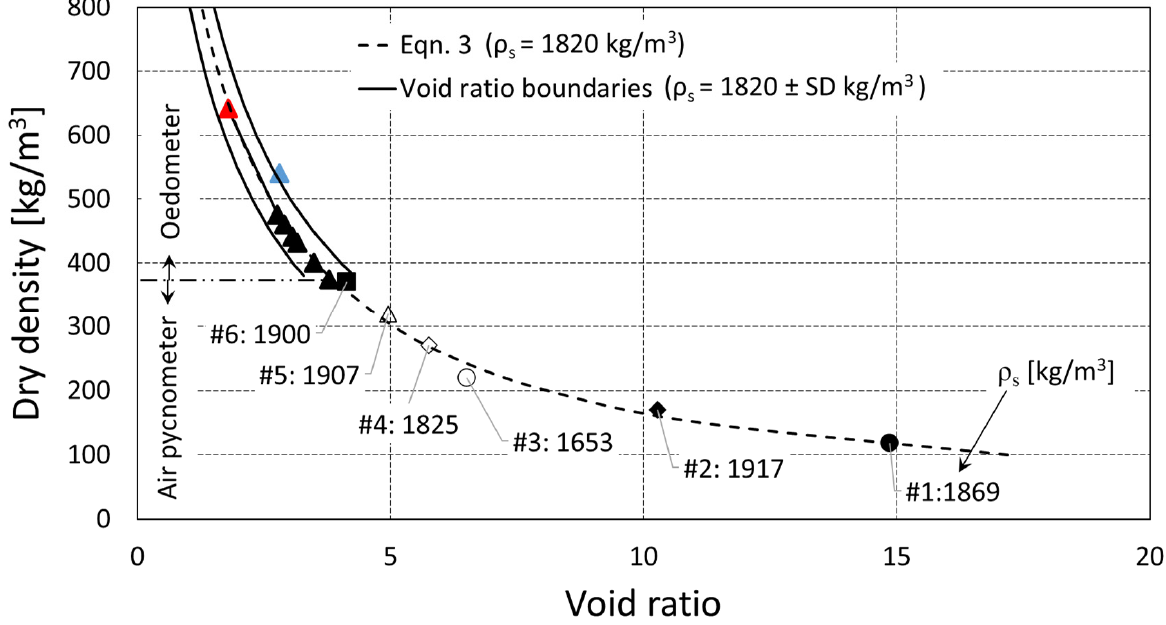
Figure 5. Coupled air pycnometer and oedometer test results.